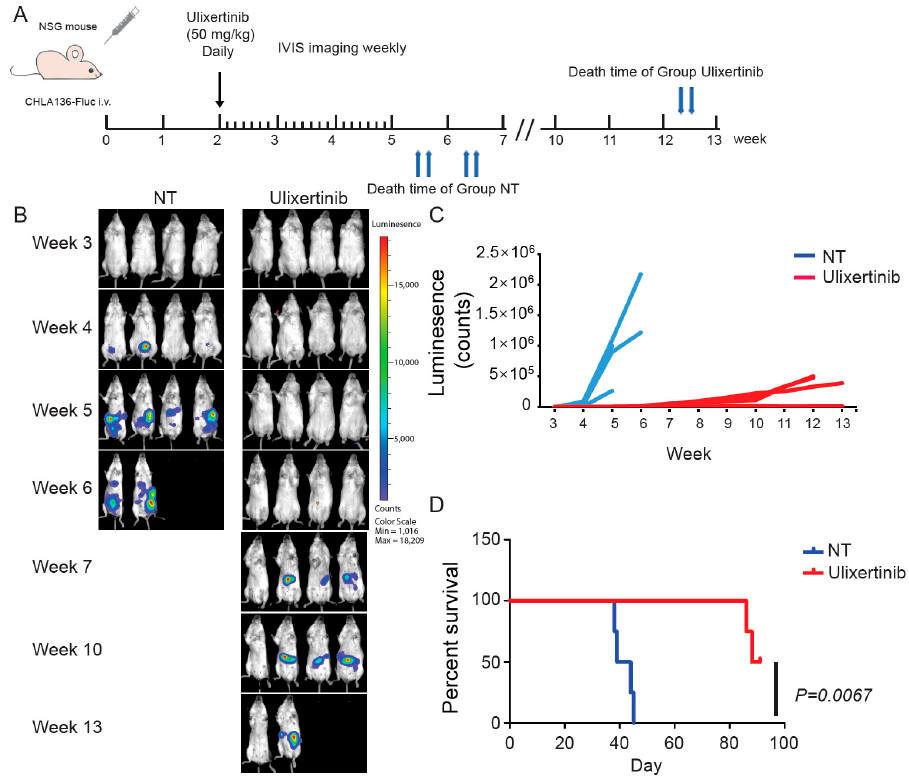
Figure 5. Ulixertinib inhibits tumor growth in the CHLA136-Fluc xenograft NB mouse model. ( A ) Treatment strategy of the xenograft NB mouse model. ( B ) Bioluminescent imaging photos of CHLA136-Fluc xenograft NB mice from the DMSO control group and the ulixertinib-treated group (50 mg/kg). ( C ) The values of bioluminescent imaging of xenograft NB mice were monitored during tumor growth. ( D ) The survival rate of CHLA136-Fluc xenograft NB mice treated with ulixertinib and control. Statistical analysis was performed by a Log-rank test. ( χ 2 = 7.344; p = 0.0067).